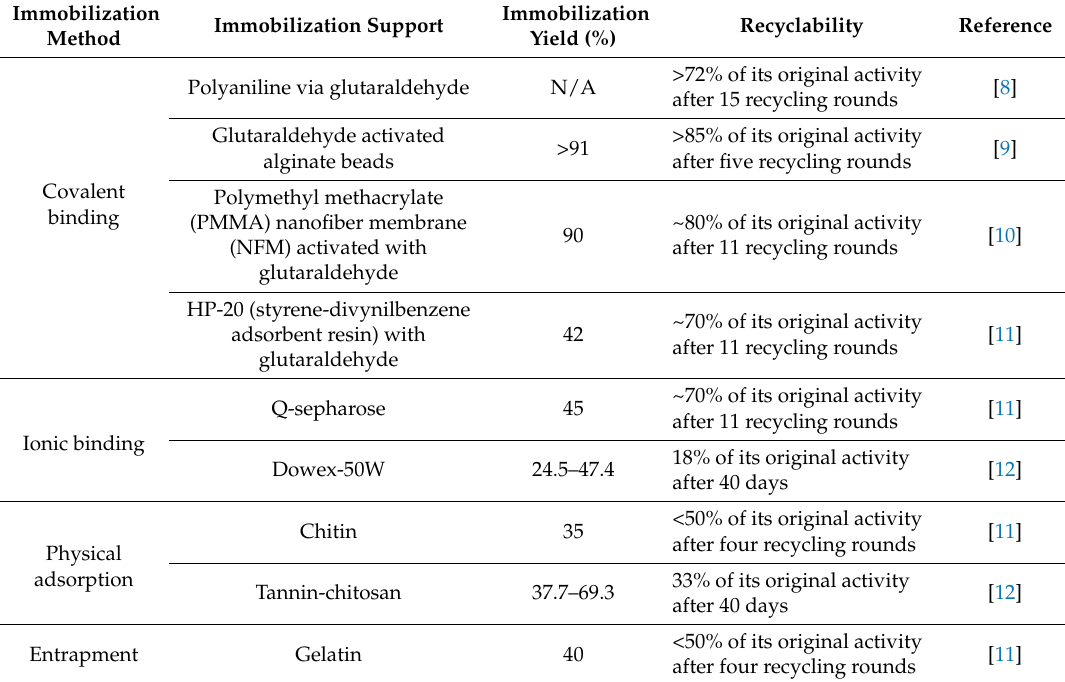
Table 1. Summary of the xylanase immobilization methods and their effect on enzyme recyclability